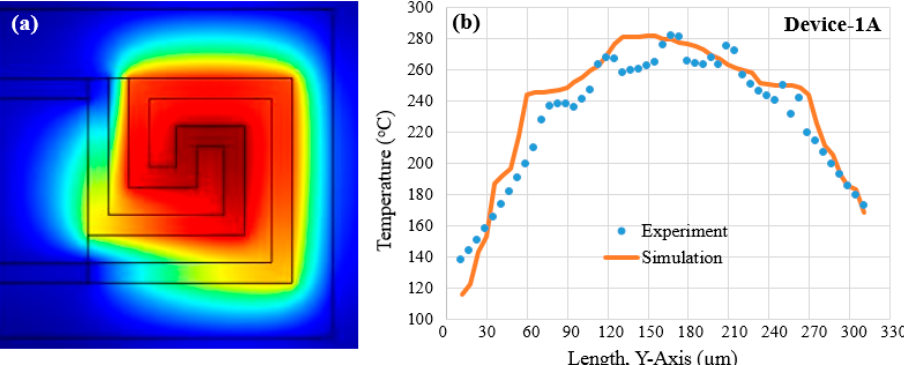
Figure 3. ( a ) Representative simulation of double meander micro-hotplate (device 1A), 281 °C at 28 mW; ( b ) Temperature distribution along y -axis for simulated and experimental values of micro- hotplate “1A” at 281